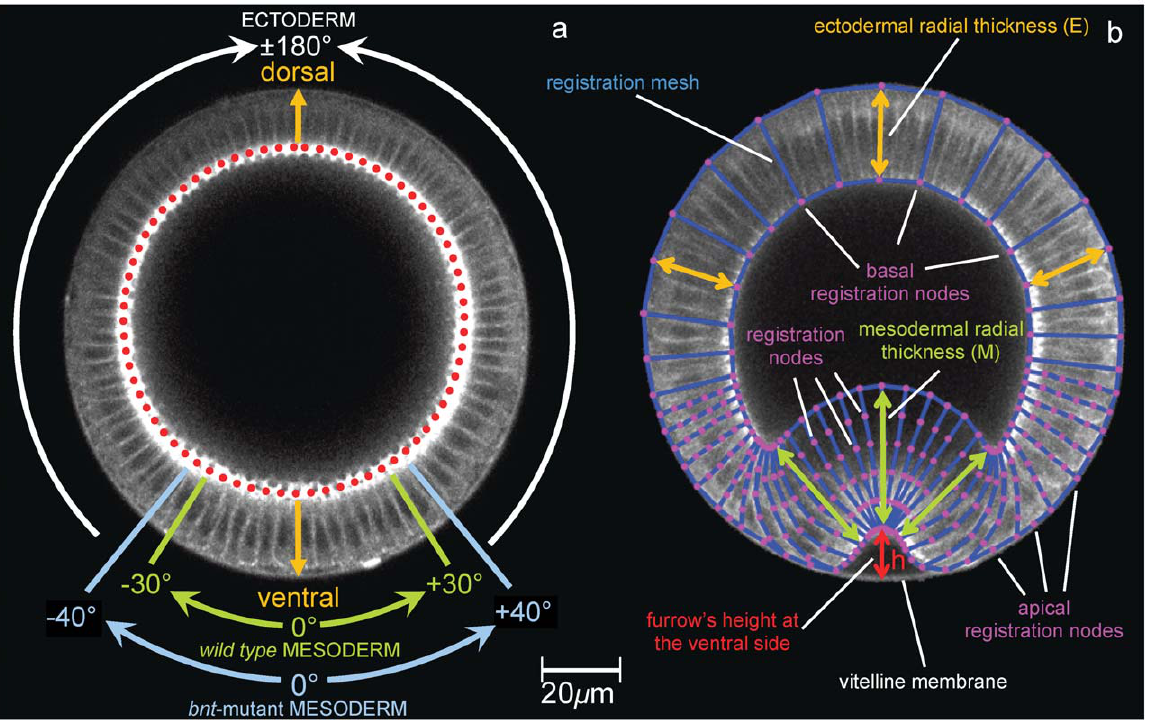
Figure 1. Digitisation procedure and epithelial fate. ( a ) The angular coordinate system is defined in the reference configuration at t= 2 10.43 min, which is considered as initial configuration. The presumptive mesoderm is defined as the tissue that ultimately forms the ventral furrow in the wt embryo. By tracking backward in time, this tissue was found to be nominally 18 cells wide in the wt embryo and to span a 6 44 u angle about the dorsal (D)-ventral (V) midline at the reference instant t= 2 10.43 min. Only a mesodermal sub-region is thought to be active by undergoing apical constriction. Myosin II that is initially localized on the basal side of the epithelium (red-dotted line) vanishes in this sub-region to reappear apically (on the opposite end of cells). In the wild type and bnt -mutant embryos, this sub-region was respectively found to span approximately 6 30 u (green lines) and 6 40 u (blue lines) astride the dorsal-ventral midline. ( b ) Digitisation procedure of an intermediate-stage frame from the in-vivo imaged sequence of a wt embryo: a polygonal mesh (blue lines) has been overlaid on the tissue to track displacements at nodal points, referred to as registration nodes (magenta dots). Polygonal partitions can correspond to single cells, multiple cells or sub-cellular regions, depending on the measurements refinement required in that particular portion of tissue. Arrows point the radial thickness of the epithelium, which was measured on the mesh as the distance between basal and apical node along the same side of a given cell. The height of the furrow (h) has been measured as that of the most ventral nodal point with respect to its position in the reference frame at t= 2 10.43 min.